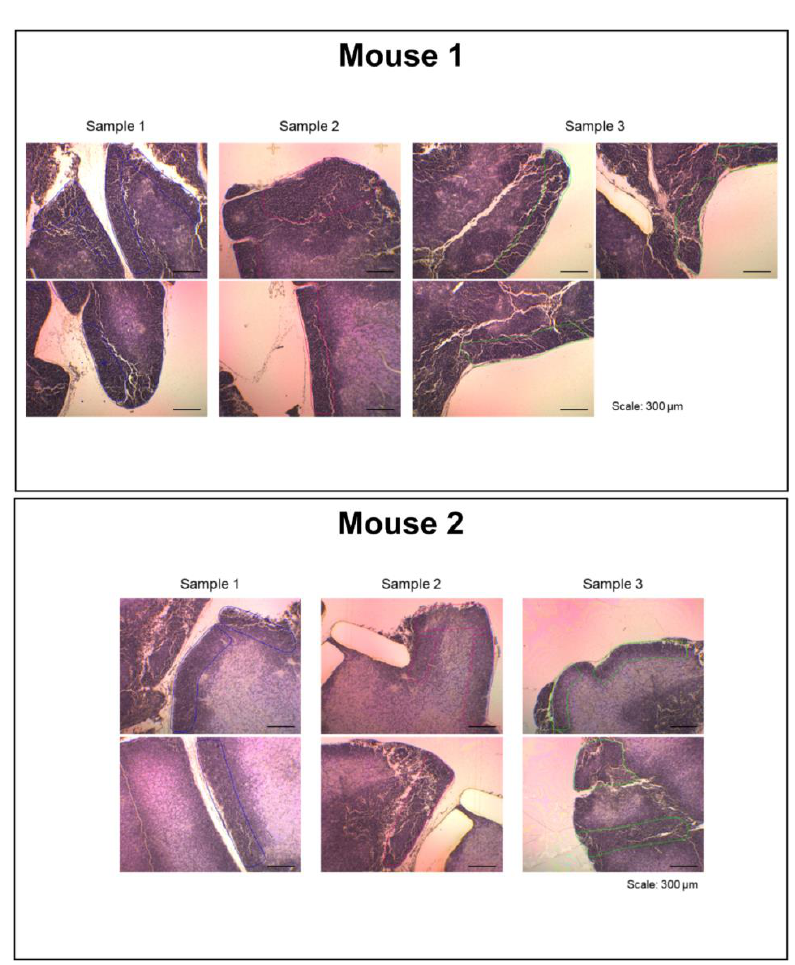
Figure 3. Tissue dissection images shown in a separate window. The display image for the thymic cortex is shown. When the region of interest within the whole section image in the main window (Figure 2) is selected, the tissue dissection images are displayed.